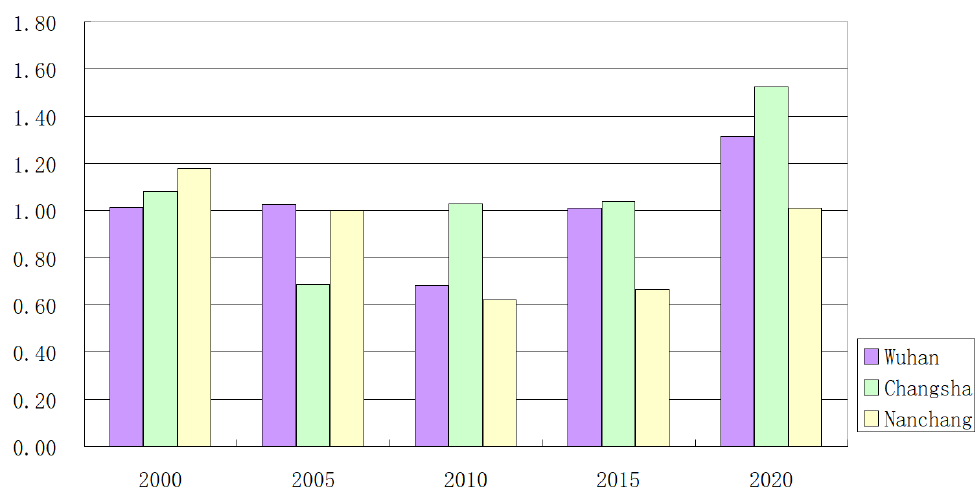
Figure 6. Capital cities’ eco-efficiency of land use.